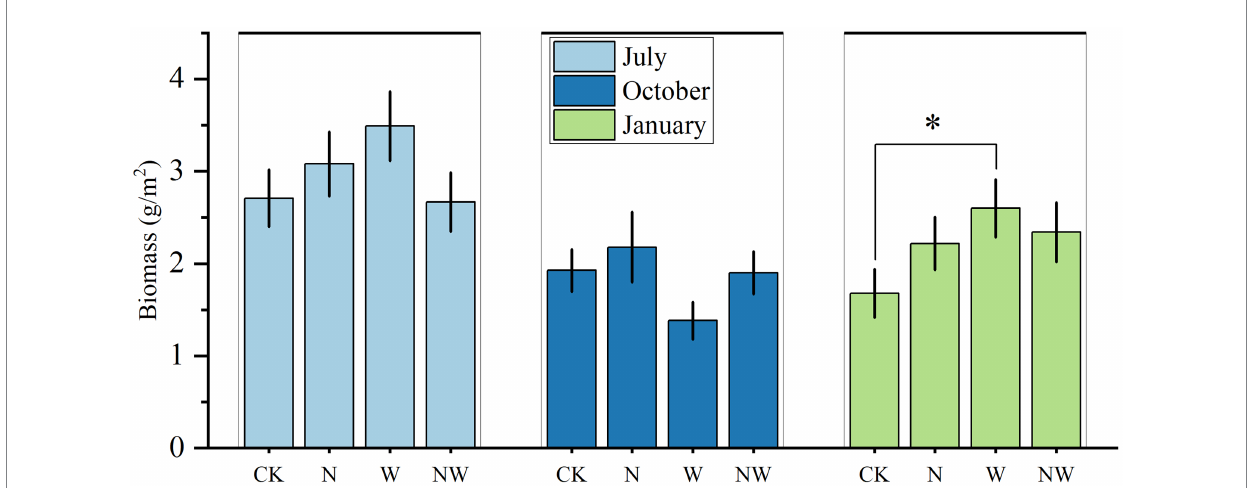
FIGURE 1 Effects of the treatments on fine root biomass in July 2018, October 2018, and January 2019. CK, control; N, canopy N addition at 25 kg ha − 1 yr. − 1 ; W, canopy water (W) addition at 30% of the local precipitation; NW, canopy N addition at 25 kg ha − 1 yr. − 1 and W addition at 30% of the local precipitation. The data are presented as means ± standard